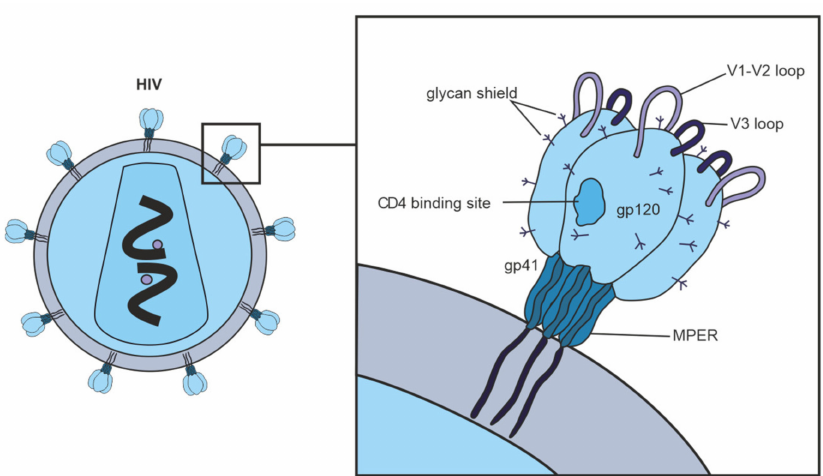
Figure 2. Vulnerable targets on trimeric glycoproteins of HIV-1 spike (gp120 and gp41). Widely neutralizing Abs target the CD4 binding site on gp120, the proximal outer membrane region of gp41, the glycan shield, and epitopes in variable loops 1, 2, and 3 on gp120. Abs against the CD4 binding site of gp120 can contribute to the overall cross-neutralizing potential of HIV-positive sera; in rare cases, the broad neutralizing activity of sera is almost exclusively due to such Abs [64,86,91]. Thus, the gp120 CD4 binding site is a promising target for vaccine